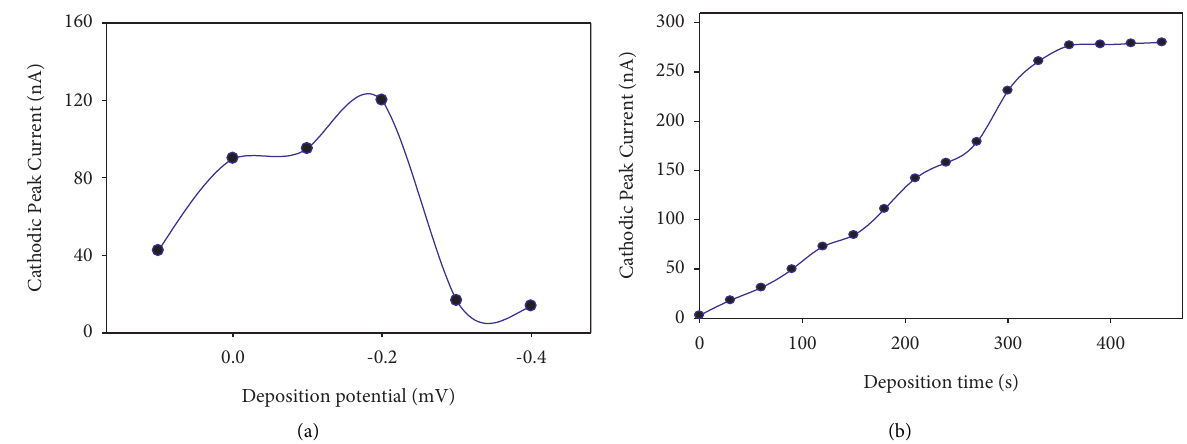
Figure 4: Plot of the cathodic peak current of the SW-CSV versus accumulation potential (a) and deposition time (b) of malathion and Cu 2+ ions in B-R buffer of pH 2 at HMDE versus Ag/AgCl reference electrode. Scan rate � 100mV/s; pulse amplitude � − 50mV.